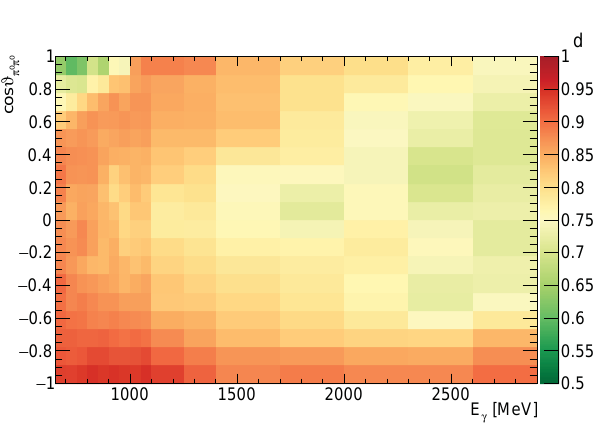
Figure 3. Dilution factor d depending on E γ and cos ϑ π 0 π 0